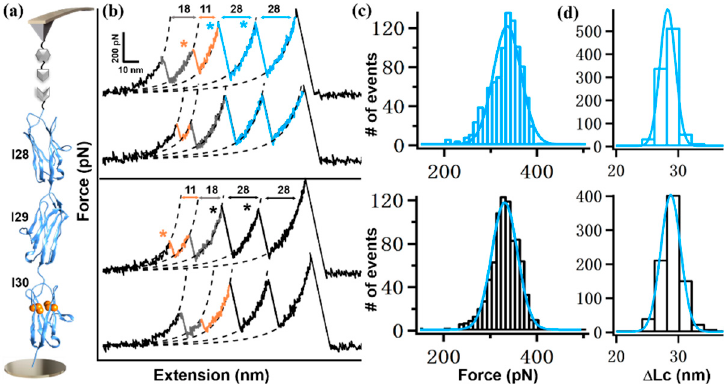
Figure 3. ( a ) Scheme of AFM-SMFS setup to measure I(28–30) domains. ( b ) Representative force- extension curves from polyprotein with linkers (top, colored in blue) and without linker (bottom, black). ( c , d ) Histograms of their corresponding unfolding force ( c ) and ∆ Lc ( d ) are shown. The star indicates the unfolding event/peak of one protein domain.